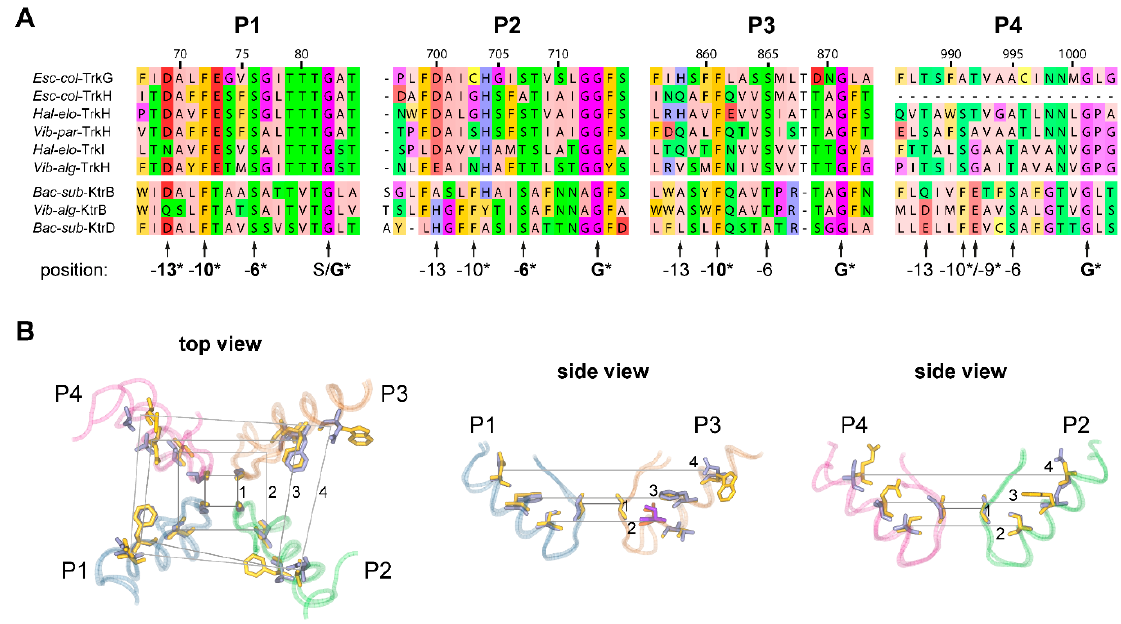
Figure 3. Conserved residues in the pore helix may stabilize the pore loops. ( A ) Sequence alignment of the pore domains P1 to P4 of Trk and Ktr. Positions above the alignment coincide with the numbering in Figure 2 for easier comparison. Selectivity filter residues and residues 6, 9/10, and 13 positions upstream of the selectivity filter are marked. The asterisk and a bold format indicate conservation of the residue in Trk and Ktr proteins, while the asterisk in normal font indicates conservation in only one of the groups Ktr or Trk. The alignment is coloured based on physicochemical properties according to the Zappo colour scheme of Jalview. ( B ) Superposition of the pore domains of KtrB (PDB ID 4J7C) and TrkH (PDB ID 6V4L) crystal structures. The protein backbone is displayed as tubes with each pore domain in a different colour. Selectivity filter residues (plane 1) and residues 6 (plane 2), 10 (plane 3), and 13 (plane 4) positions upstream are presented in licorice. Residues from TrkH are blue, those from KtrB yellow. The side view of P3 additionally illustrates the orientation of the residue 5 positions upstream of the selectivity filter in orange (KtrB) and purple (TrkH).